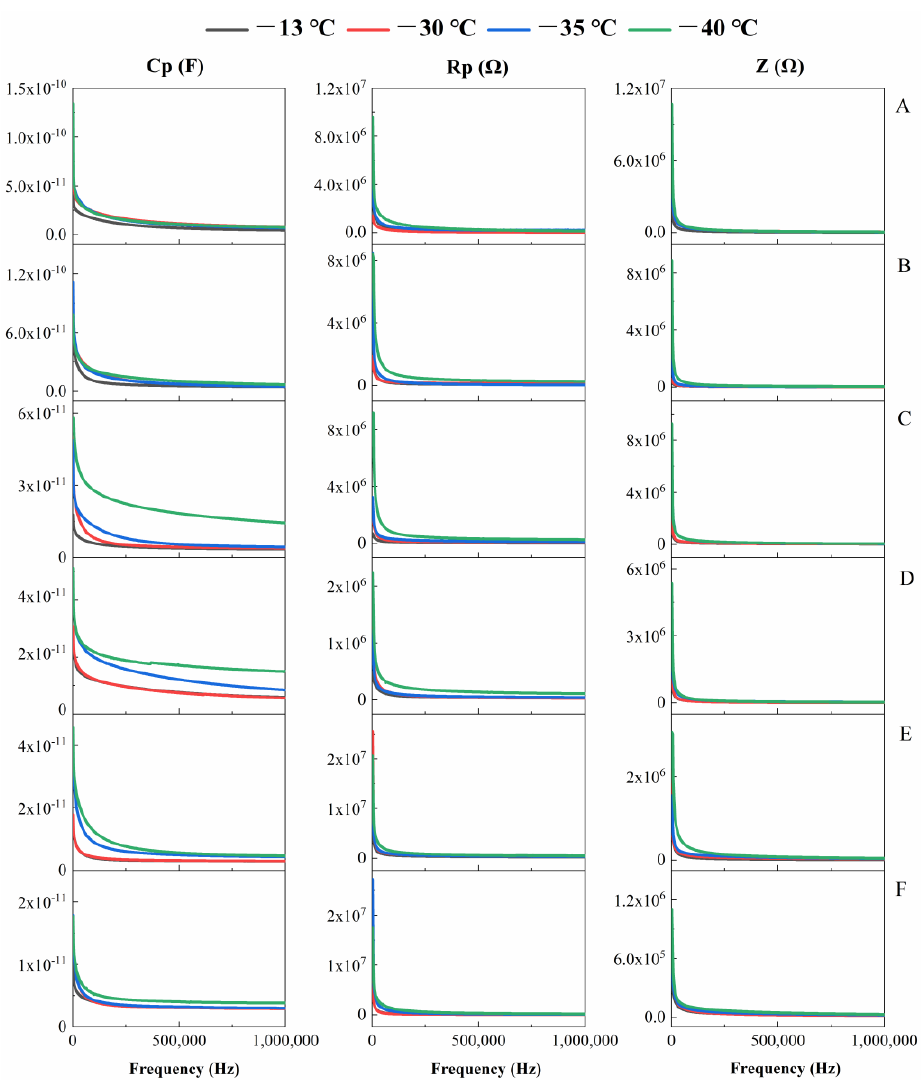
Figure 4. Effects of different freezing times and temperatures on the parallel equivalent capacitance Cp, parallel equivalent resistance Rp and complex impedance Z of sea buckthorn berries. (( A ), 0 d; ( B ), 15 d; ( C ), 30 d; ( D ), 45 d; ( E ), 60 d; ( F ), 75 d). The data are mean values of five replicates.